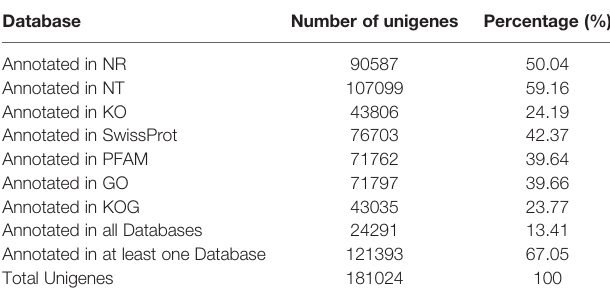
TABLE 3 | The annotated gene number of unigenes and percentage. Database Number of